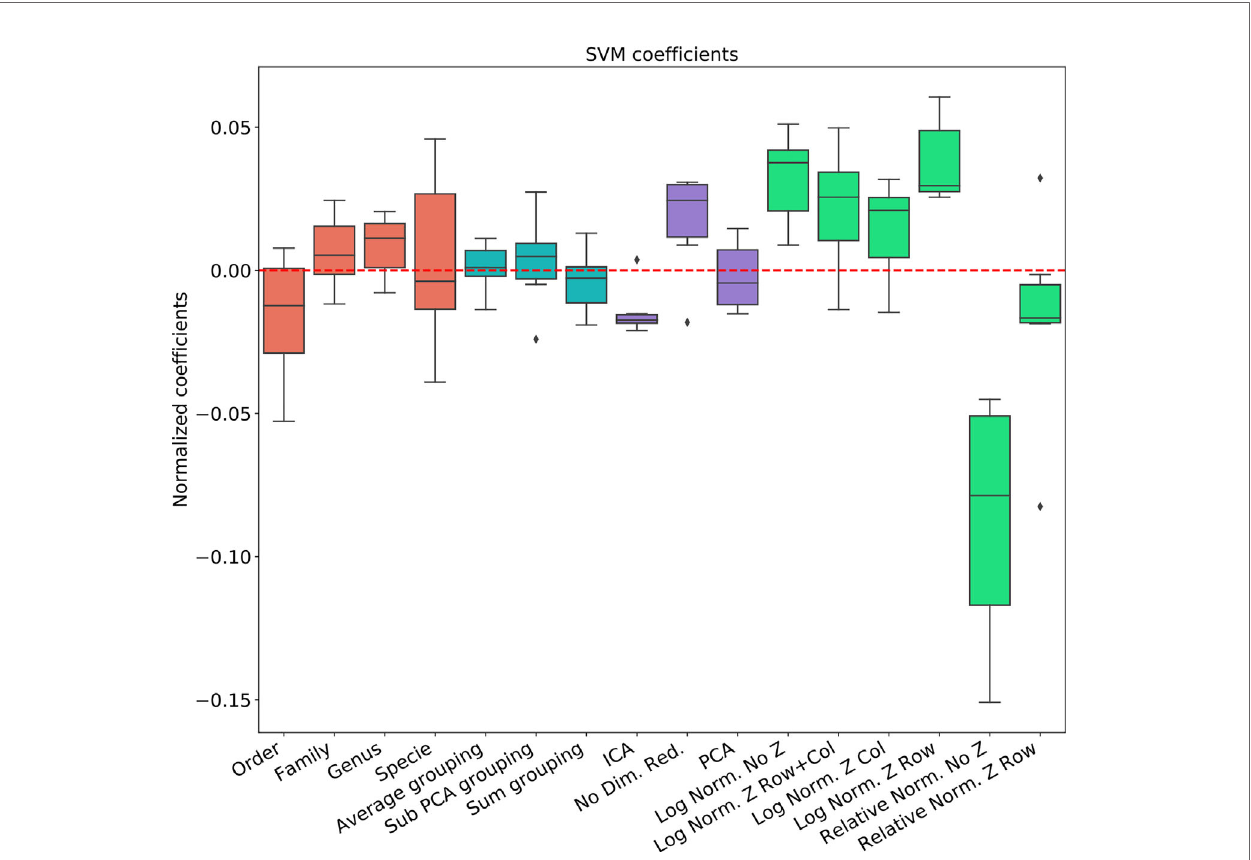
FIGURE 3 | Linear regression coef fi cient for SVM classi fi er. Coef fi cients are the contribution of a choice to the total AUC. Each group of coef fi cients is marked by a different color and normalized to 0. The following two fi gures follow this fi gure, but for different classi fi ers. The regression is over all parameter combinations, including the choice of taxonomy level (red), the grouping method (blue), the dimension reduction method (purple) and the normalization method (green). Since not all normalization and standardization methods are possible, we opened all tested